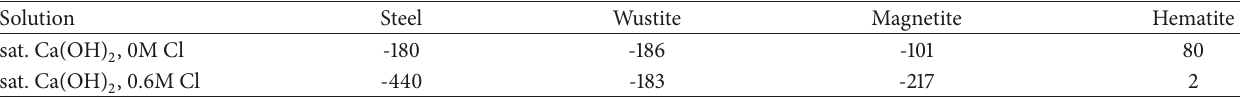
Table 4: Corrosion potential vs. Ag/AgCl sat. KCl [mV]: average value of two samples during 10